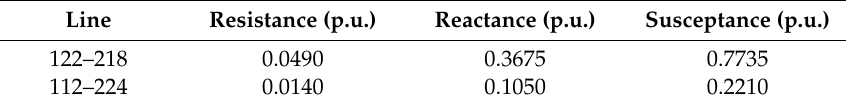
Table 2. Basic parameters, initial controlling modes and setting values of VSCs.